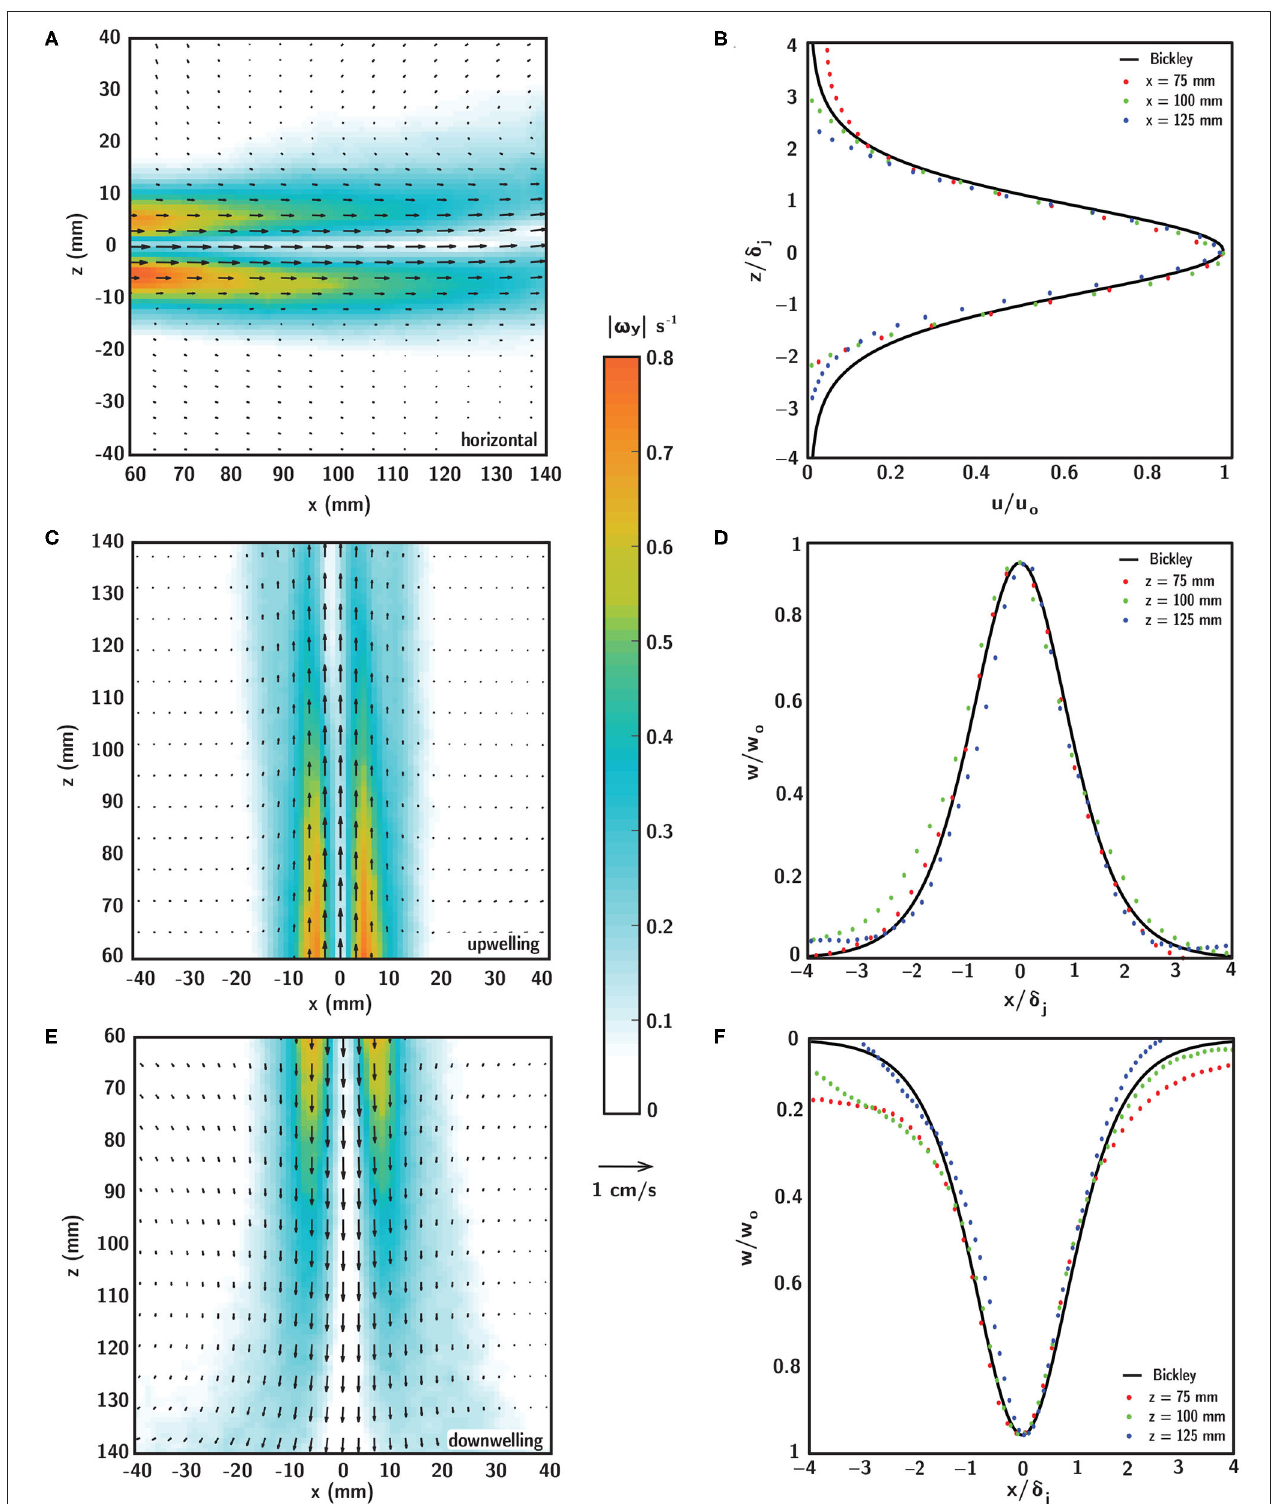
FIGURE 6 | Time-averaged fluid velocity (black vectors) and vorticity magnitude (contours) fields in (A) horizontal, (C) upwelling, and (E) downwelling shear layers generated by a laminar, planar free jet at Re j = 52. Comparison of analytical (Bickley) and experimental (PIV) self-similar velocity profiles extracted at various streamwise locations for the (B) horizontal, (D) upwelling, and (F) downwelling shear layers. Scaling parameters for the velocity profiles in (B,D,F) are defined in Equation (7).